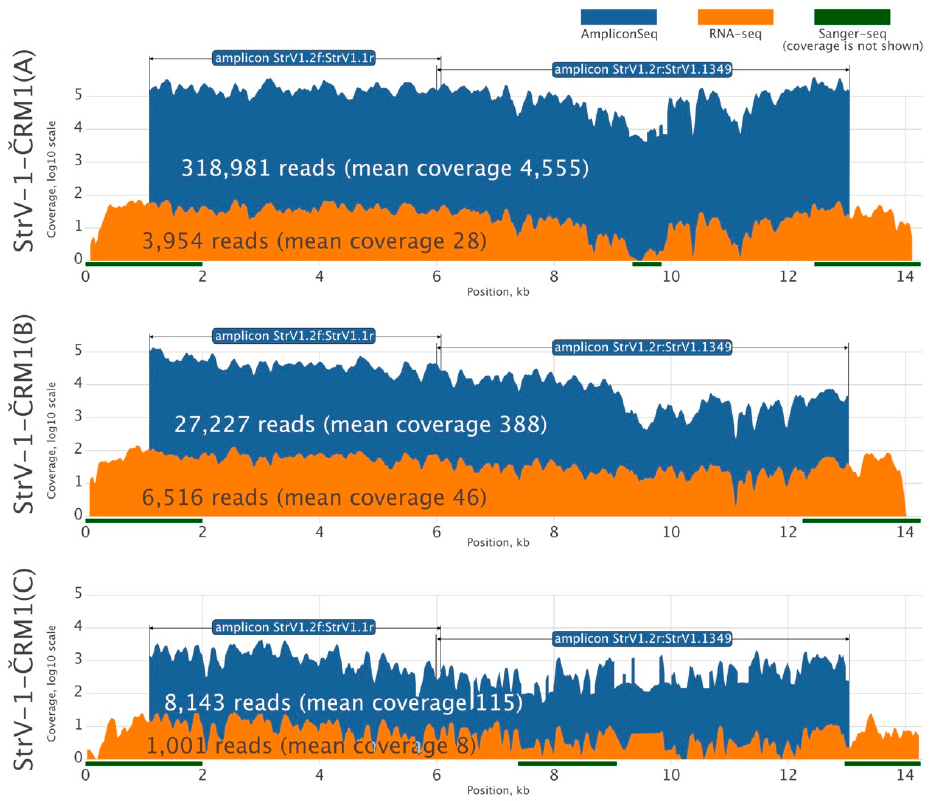
Figure 2. Overview of high-throughput sequencing of genomic A, B, and C genotypes of the isolate Č a č anská raná M1 of strawberry virus 1 (StrV-1- Č RM1). Sequence coverages obtained after RNA-Seq and Ion Proton amplicon sequencing are shown in dark orange and blue, respectively. Sanger-sequenced regions are shown as green